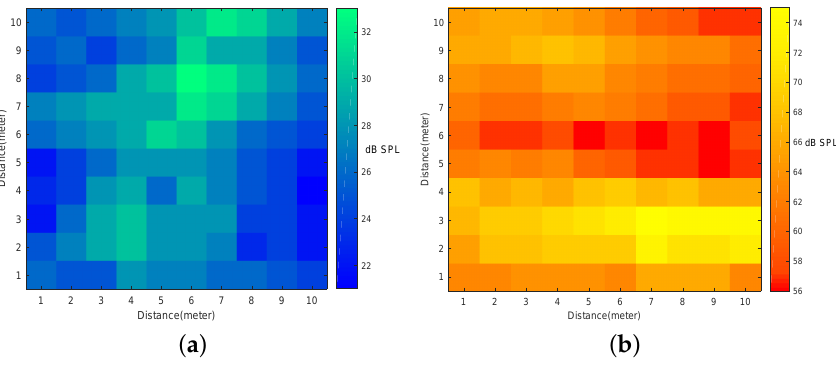
Figure 7. ( a ) the noise map of the underground parking lot; and ( b ) the noise map of the shopping